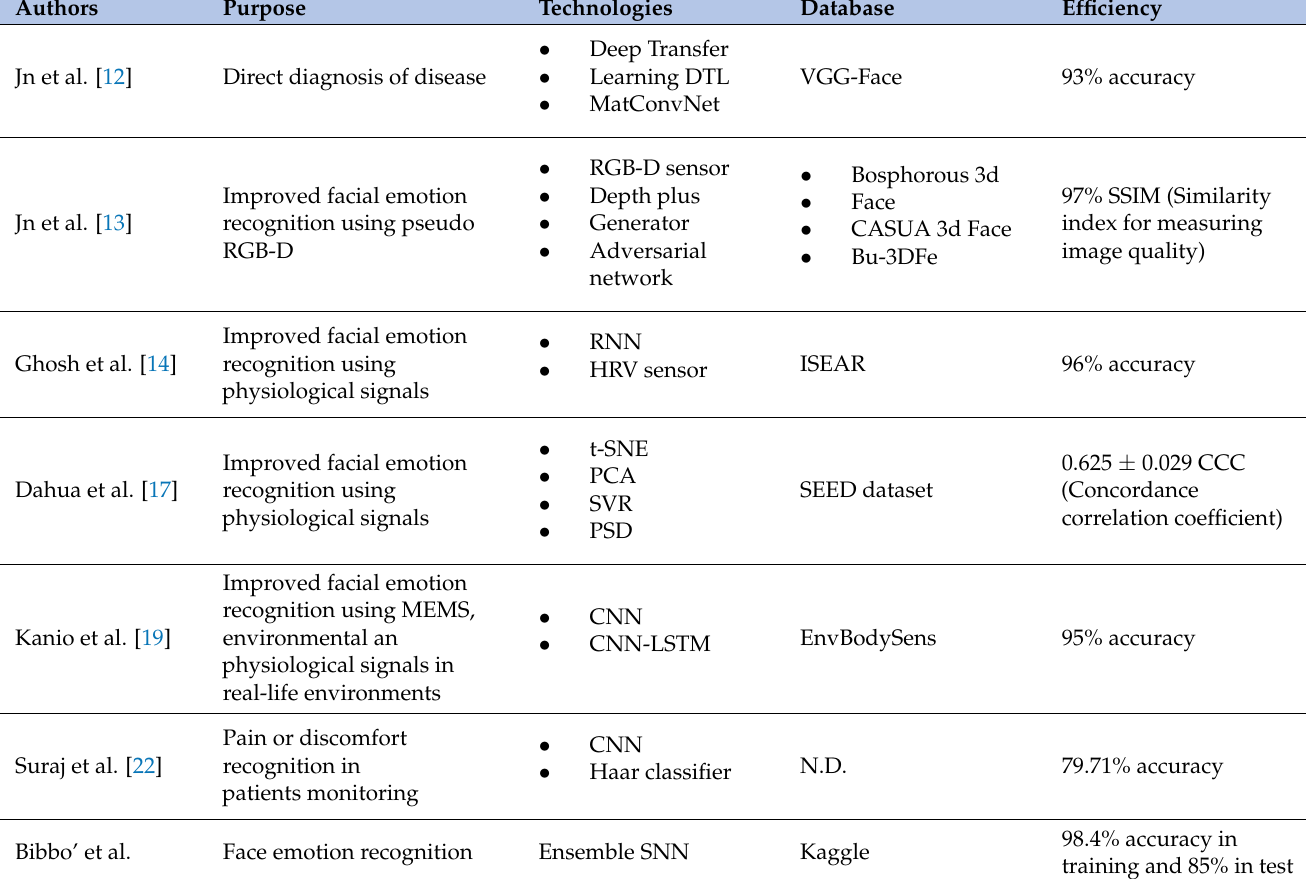
Table 4. Comparison of face emotion recognition